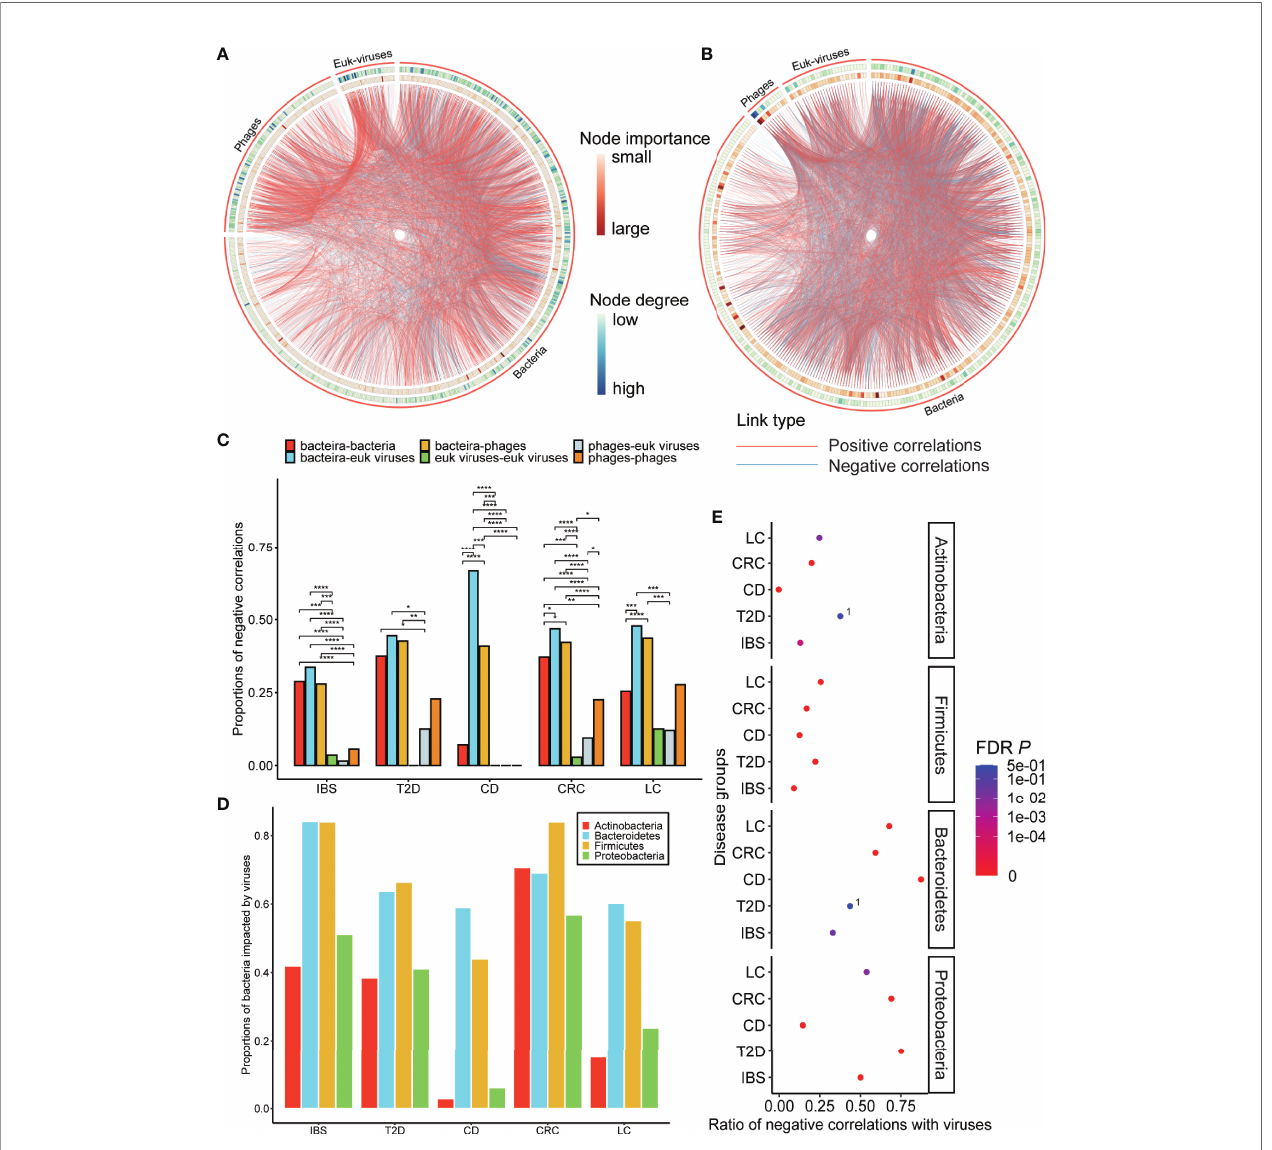
FIGURE 4 | Characterization of disease-speci fi c co-abundance relationships of viruses. (A) IBS-speci fi c network. (B) Pan-network of fi ve disease-speci fi c networks in family level. (A, B) The co-abundance networks of the gut microbiome, including bacteria, phages, and eukaryotic viruses. The two ends of each edge represent two nodes (genus) that have interaction. Three types of annotations are outside the nodes: the outermost circles of the ribbon indicate three classes of the node; the two circles of the heatmap represent the node importance centrality and the node degree, which is de fi ned as the number of nodes that link to each node. (C) Histogram of negative correlation ratios within and between three classes of nodes: bacteria, phages, and eukaryotic viruses in each disease-speci fi c network ( “ * ” ; FDR p < 0.05, “ ** ” ; FDR p < 0.01, “ *** ” ; FDR p < 0.001, “ **** ” ; FDR p < 0.0001). (D) Proportion of four bacterial phyla that link to viruses. (E) Ratio of negative correlations of four bacterial phyla that link to viruses. Points with label “ 1 ” denote FDR p > 0.05. The p -values were calculated two-sided, so the negative correlation ratio close to 0 or 1 and FDR p < 0.05 means the positive correlation ratio or the negative correlation ratio (respectively) was enriched in the relationships between that bacteria and viruses. The negative link ratio in Proteobacteria and Bacteroidetes and the positive link ratio in Firmicutes and Actinobacteria were signi fi cantly higher than the random ratio (permutation test, FDR p is shown in the fi